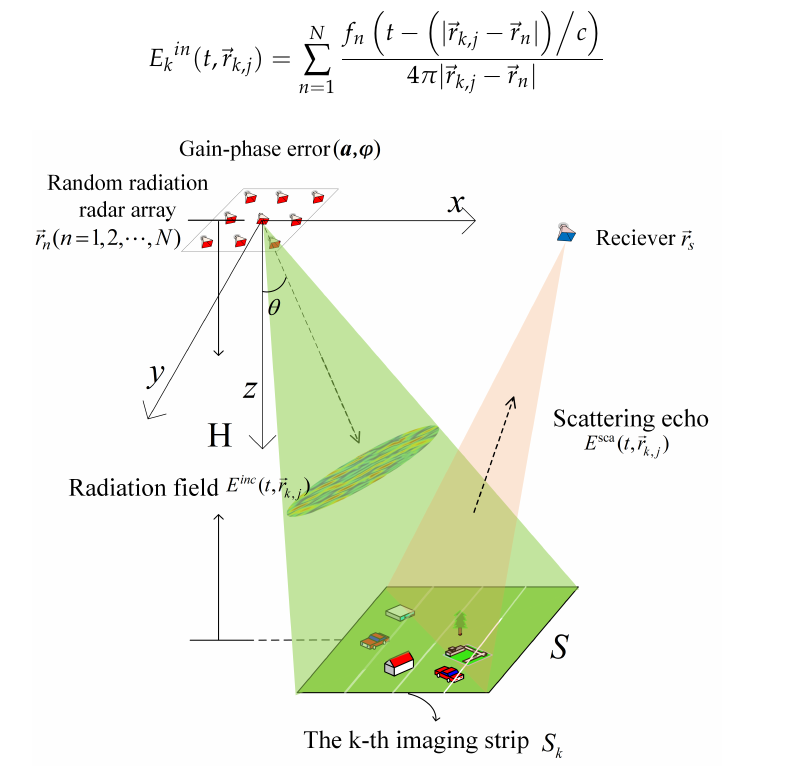
Figure 1. Geometry of